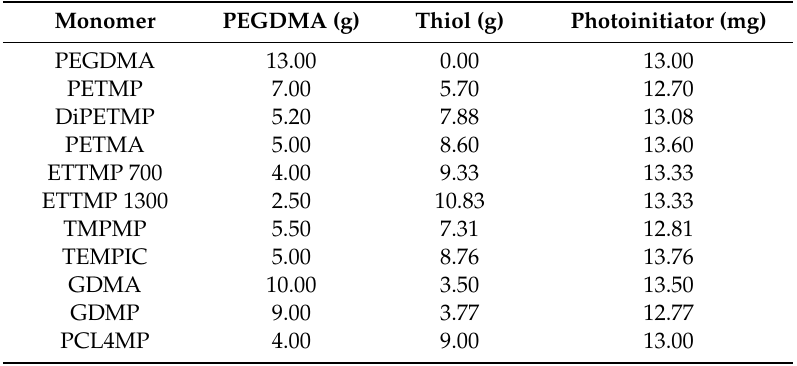
Table 1. Combination of monomers in 1:1 molar